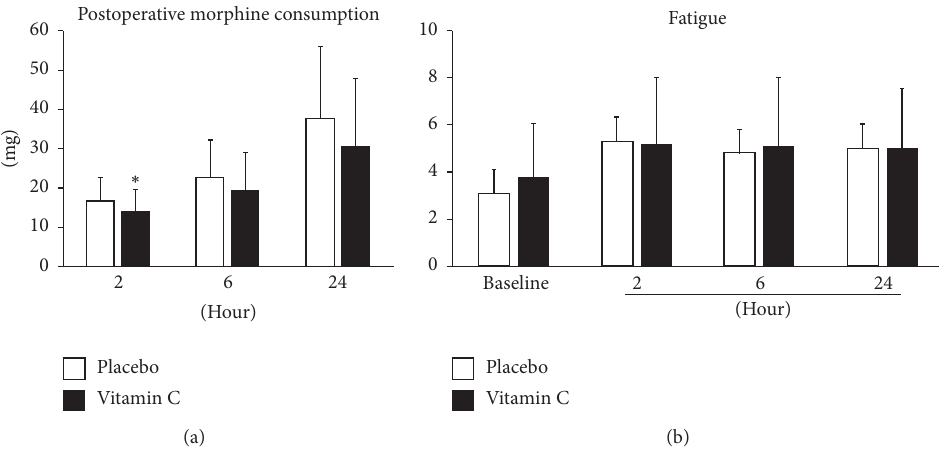
Figure 3: Postoperative morphine consumption (a) at 2, 6, and 24 h after surgery and numeric rating scores of fatigue (b) before surgery and at 2, 6, and 24 h after surgery. Data are shown as means ± standard deviation. ∗ 𝑃 < 0.05